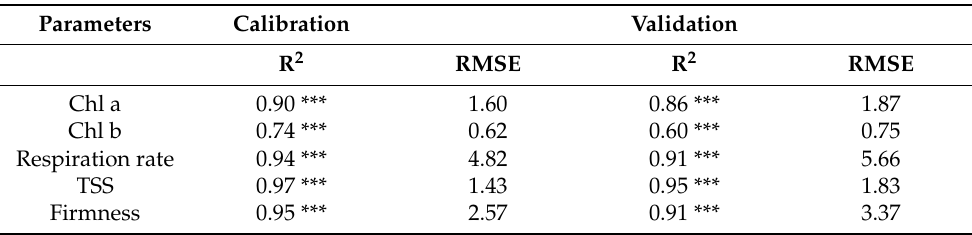
Table 7. Results of SVMR calibration and validation models for the relationship between SRIs and Chl a, Chl b, respiration rate, TSS, and firmness of banana fruits.